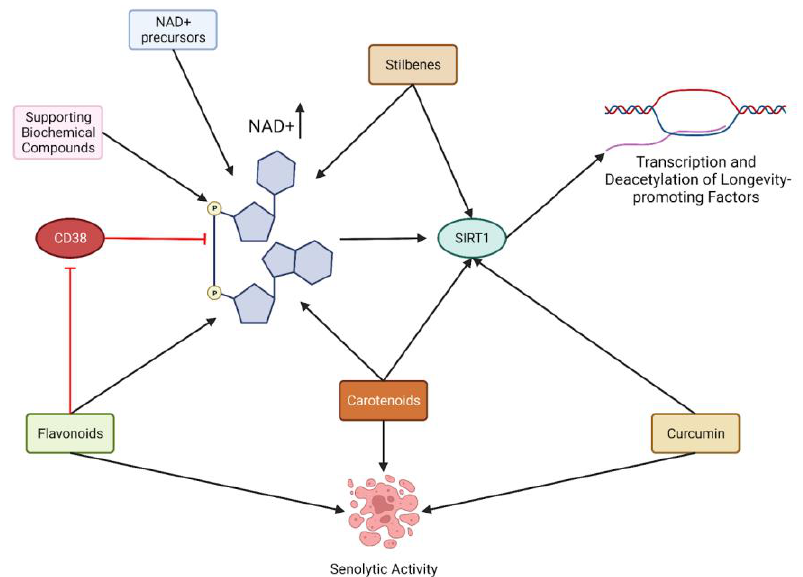
Figure 3. Hypothesized model of supplementing NAD+ precursors with other NAD+ enhancing geroprotectors. In addition to NAD+ precursors to raise NAD+ levels and enhance SIRT1 activity, stilbenes are able to support NAD+ levels and further activate SIRT1. Many flavonoids retain senolytic and CD38-inhibitory activity and can further innervate NAD+ stores. Curcumin and carotenoids retain similar properties in addition to SIRT1 activation. This interacting web of support may result in higher NAD+ stores than precursor-alone administration, producing longevity-promoting transcriptional benefits.